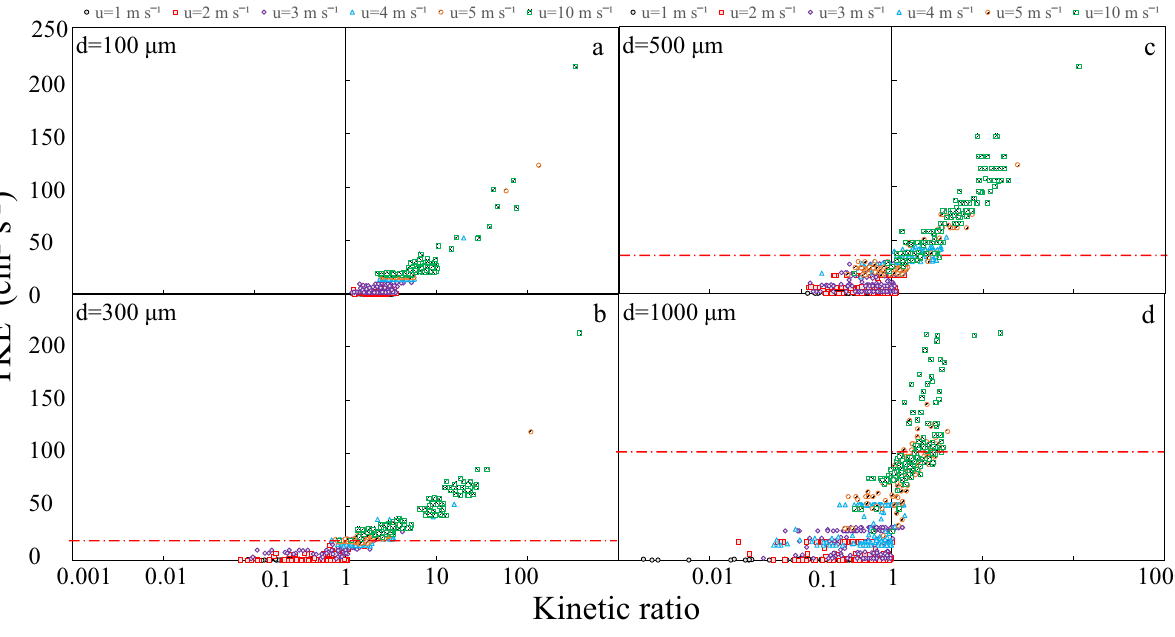
Figure 7. Relationship between kinetic ratio and TKE: ( a ) 100 µm, ( b ) 300 µm, ( c ) 500 µm, ( d ) 1000